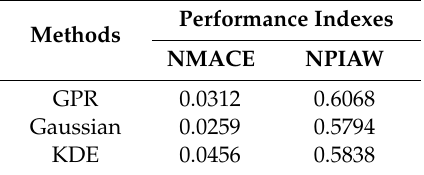
Figure 12. Single-step wind power prediction considering sequential uncertainties. Table 6. Comparison of interval prediction performance via different methods.